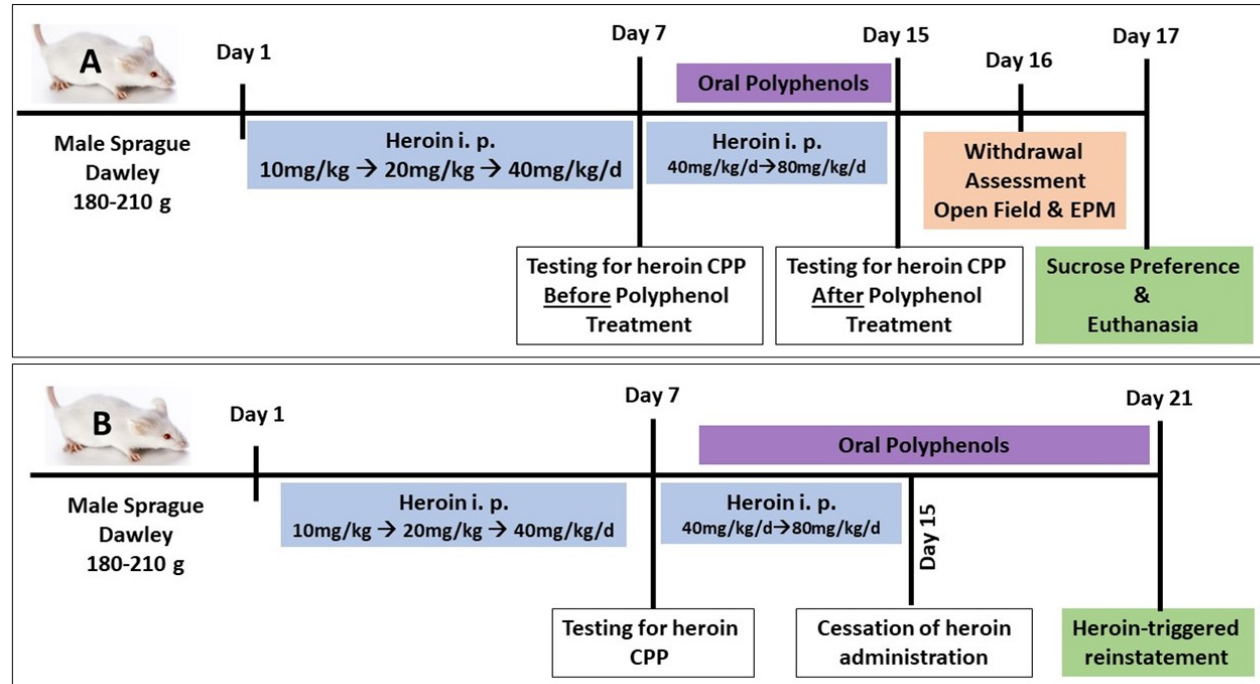
Figure 1. Study design: ( A ) naloxone-precipitated opiate withdrawal cohort; ( B ) heroin-triggered reinstatement cohort.